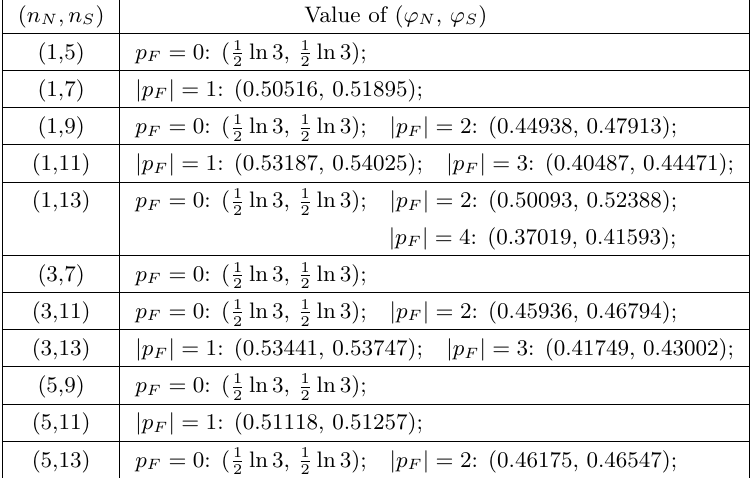
Table 1 . Values of the scalar field ϕ at the north and south pole, ( ϕ N , ϕ S ), for some representative AdS 3 × Σ solutions for spindle data n N , n S and flavour flux p F . In general we have n S − n N even. The p F = 0 solutions exist when n S − n N is divisible by four; these are the analytic solutions of section